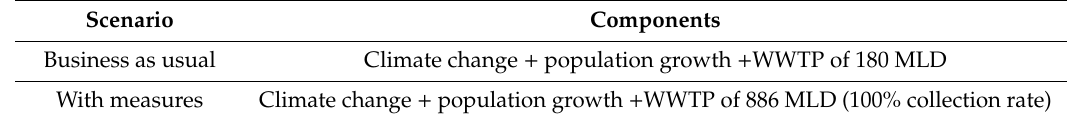
Table 2. Summary of all the criteria considered for di ff erent scenarios in future water quality simulation.